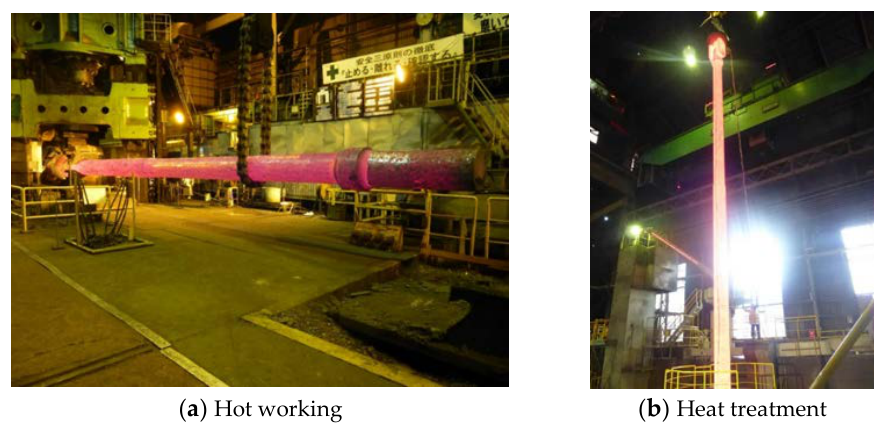
Figure 3. Photographs of the manufacturing process.